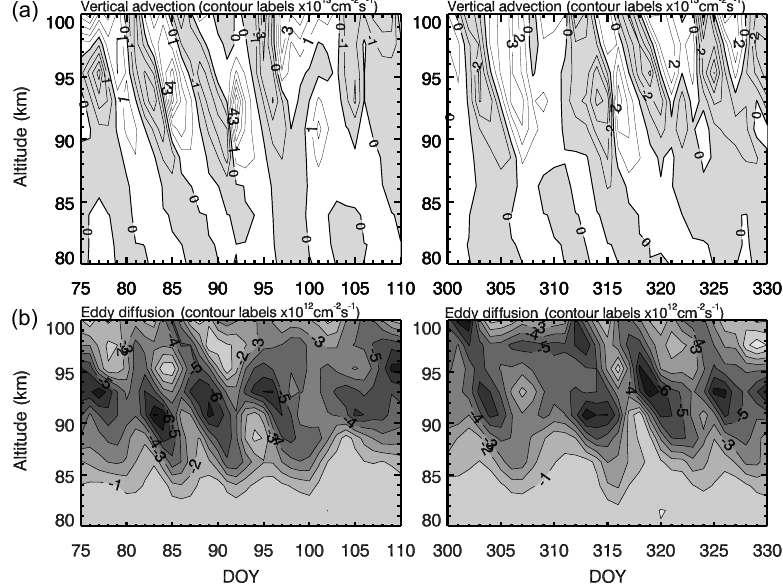
Figure 5. Daily mean transport of atomic oxygen by vertical advection (a) and eddy diffusion (b) at 43 ◦ N and 143 ◦ E. Contour labels